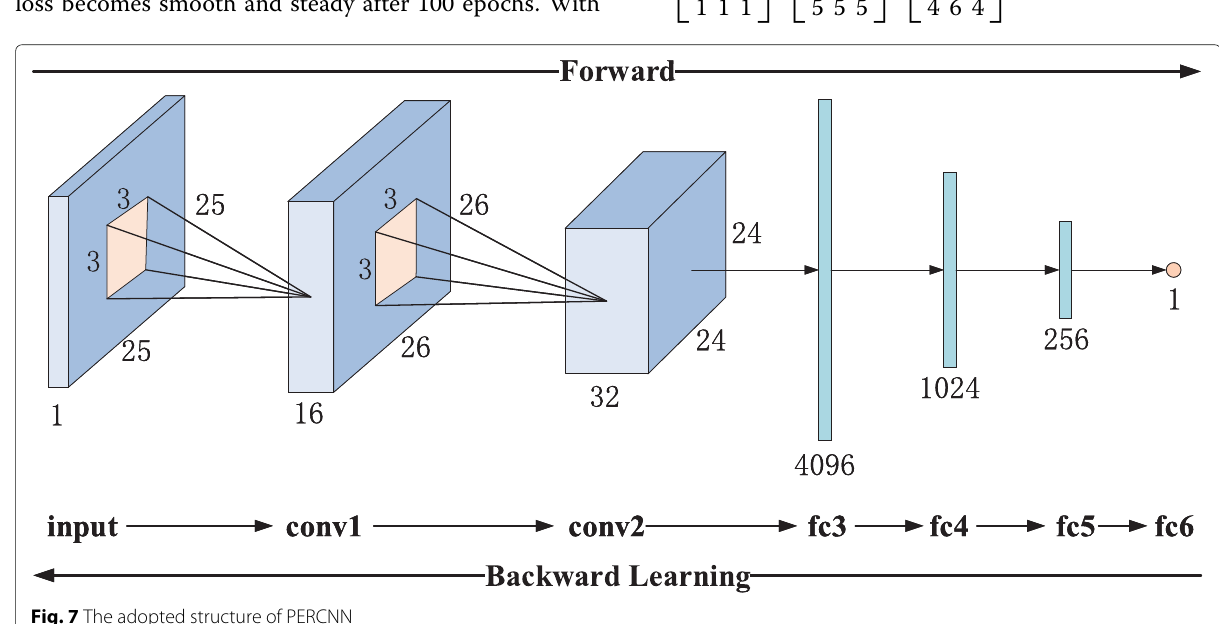
Fig. 7 The adopted structure of